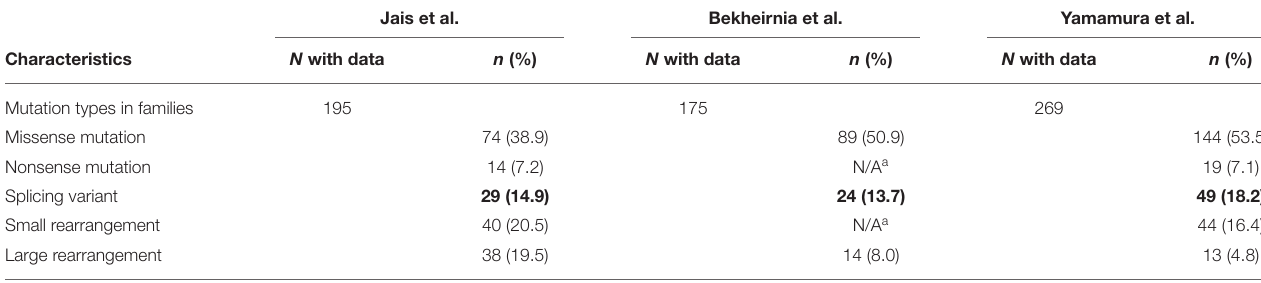
TABLE 1 | Mutational characteristics of reported cohort of X-linked Alport syndrome.